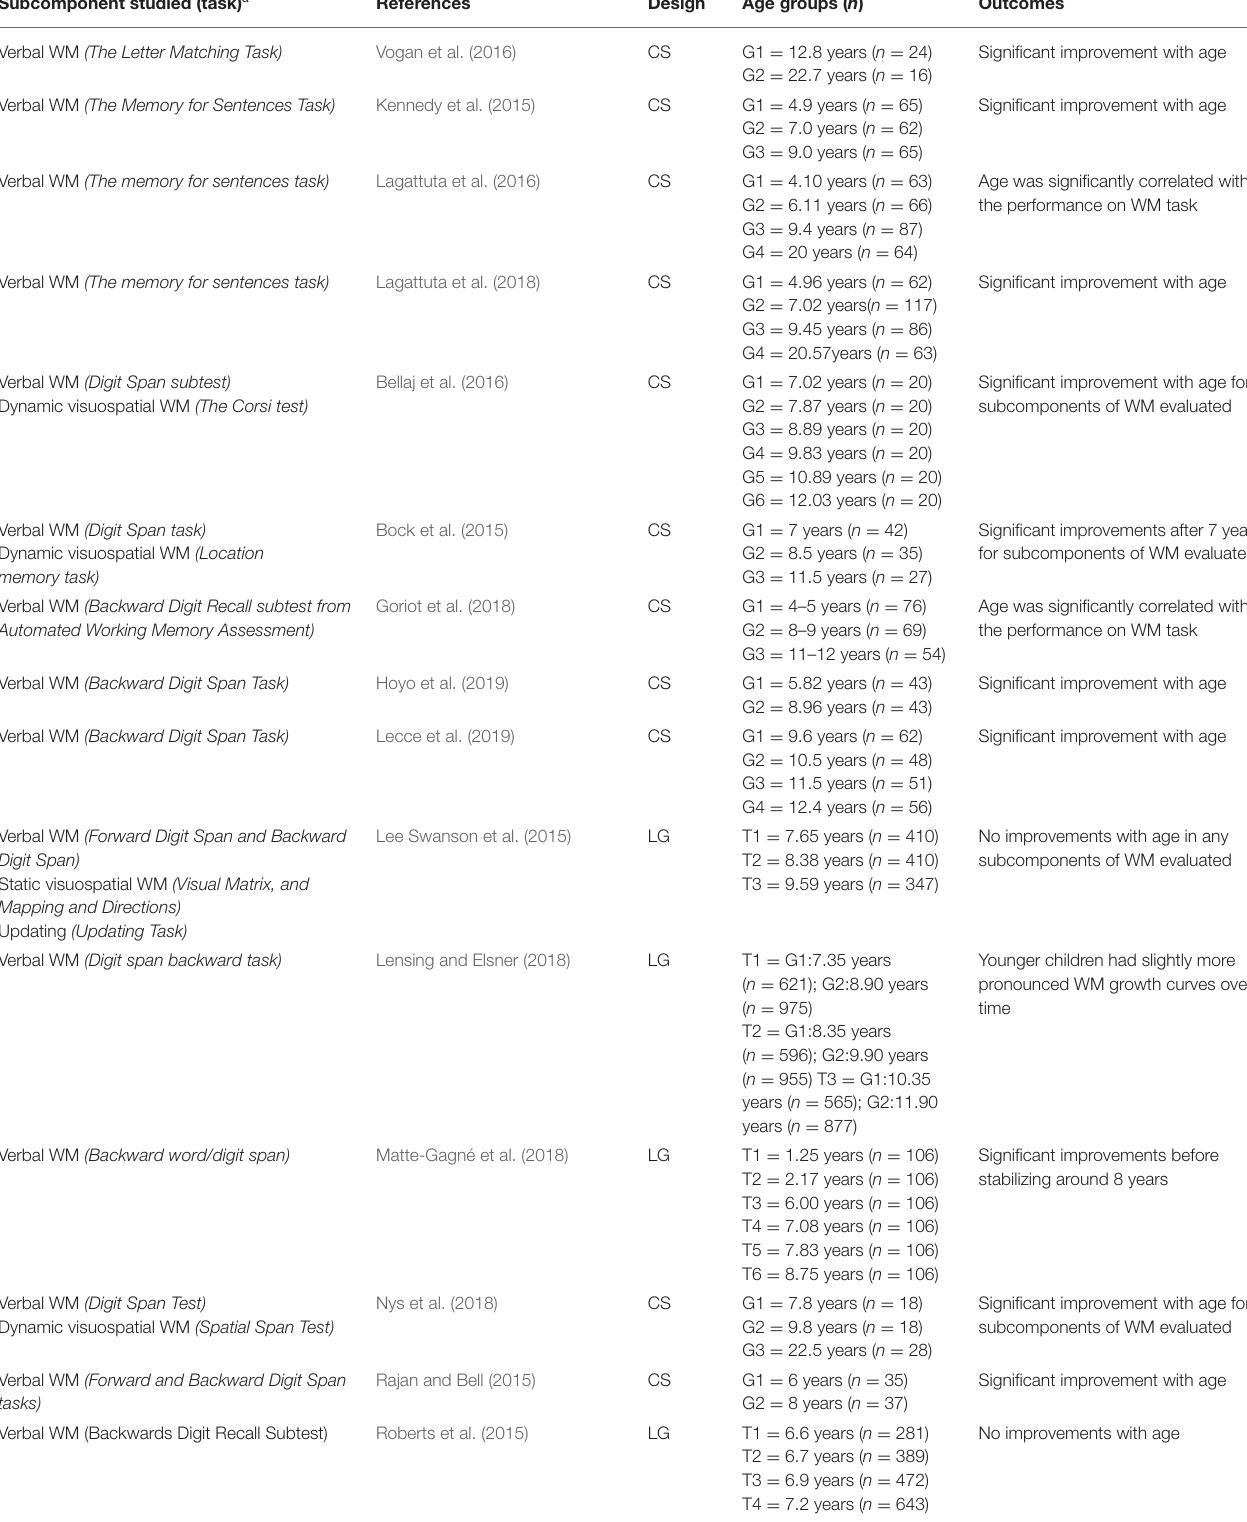
TABLE 1 | Studies on the development of the working memory–WM ( n =